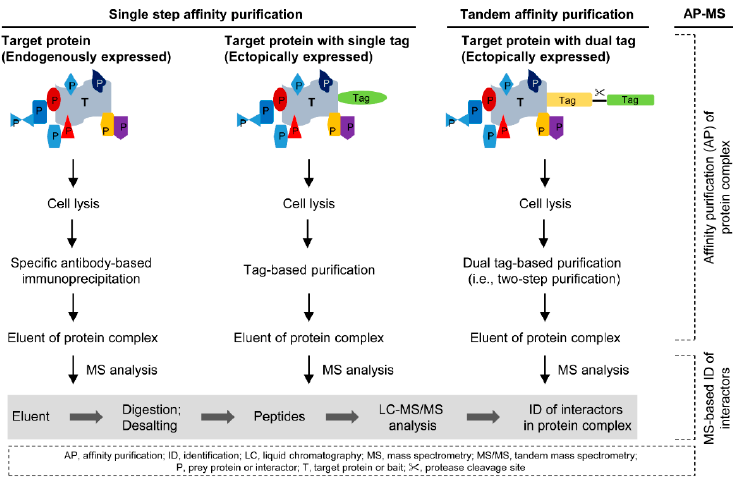
Figure 1. Schematic presentation of the general principle of affinity purification coupled with mass spectrometry (AP-MS) approach. The outlines of single step and tandem affinity purification of protein complex are shown. The purification process is performed once and twice, respectively, in single step and tandem affinity purification approaches. The eluent of the protein complex is subjected to enzymatic digestion and subsequent MS analysis to identify the interactors of the target protein. The sizes of target and prey proteins do not reflect their molecular weights. The different colors/shapes indicate different prey proteins or tags. The gray color box highlights the MS analysis part of AP-MS approach. The figure is drawn based on the concepts described in multiple studies [3,4,12–16].